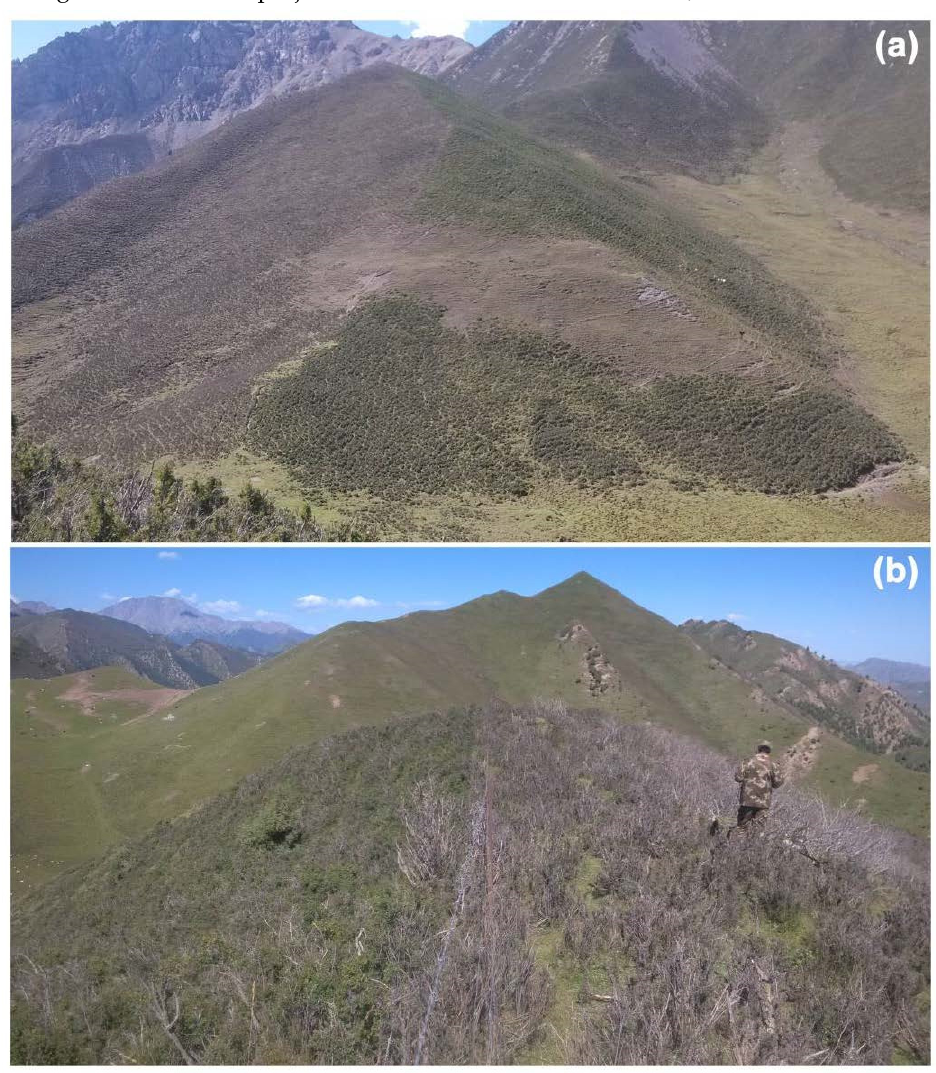
Figure 12. Effect of different domestic animals on vegetation cover in the subalpine shrub. Note: ( a , b ) are a full and close shot of the subalpine shrub-meadow zone, respectively. The ridge in ( a ) is covered by fence with the left side mainly being grazed by yak and the right side by goats. The left side of the fence in ( b ) was mainly grazed by goats, and the right side was mainly grazed by yaks. The photos were taken at Toutan (3400 m a.s.l.) in the subalpine shrub-meadow zone of the middle Qilian Mountains.